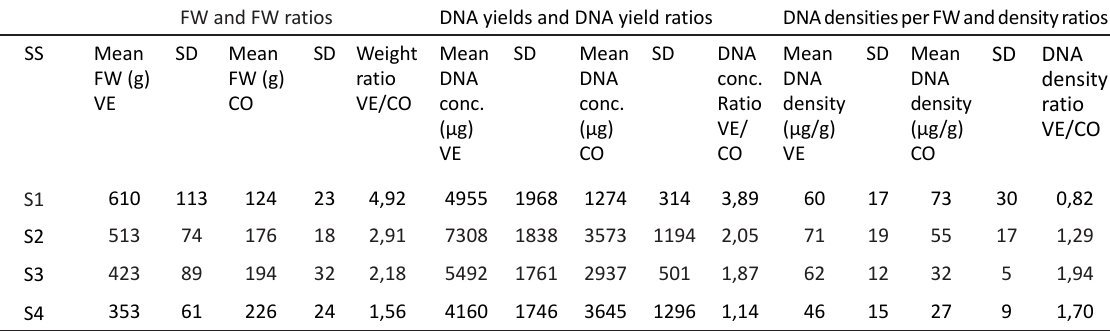
Table 1. Mean fresh weights (FW), DNA yields, DNA densities and their ratios between different maize plant parts at different sampling stages (SS). Per sampling stage, a total of 10 plants was taken (n = 10) and studied further. FW and FW ratios DNA yields and DNA yield ratios DNA densities per FW and density ratios SS Mean SD Mean SD Weight Mean SD Mean SD DNA Mean SD Mean FW (g) FW (g) ratio DNA DNA conc. DNA DNA VE CO VE/CO conc. conc. Ratio density density (µg) (µg) VE/ (µg/g) VE CO CO